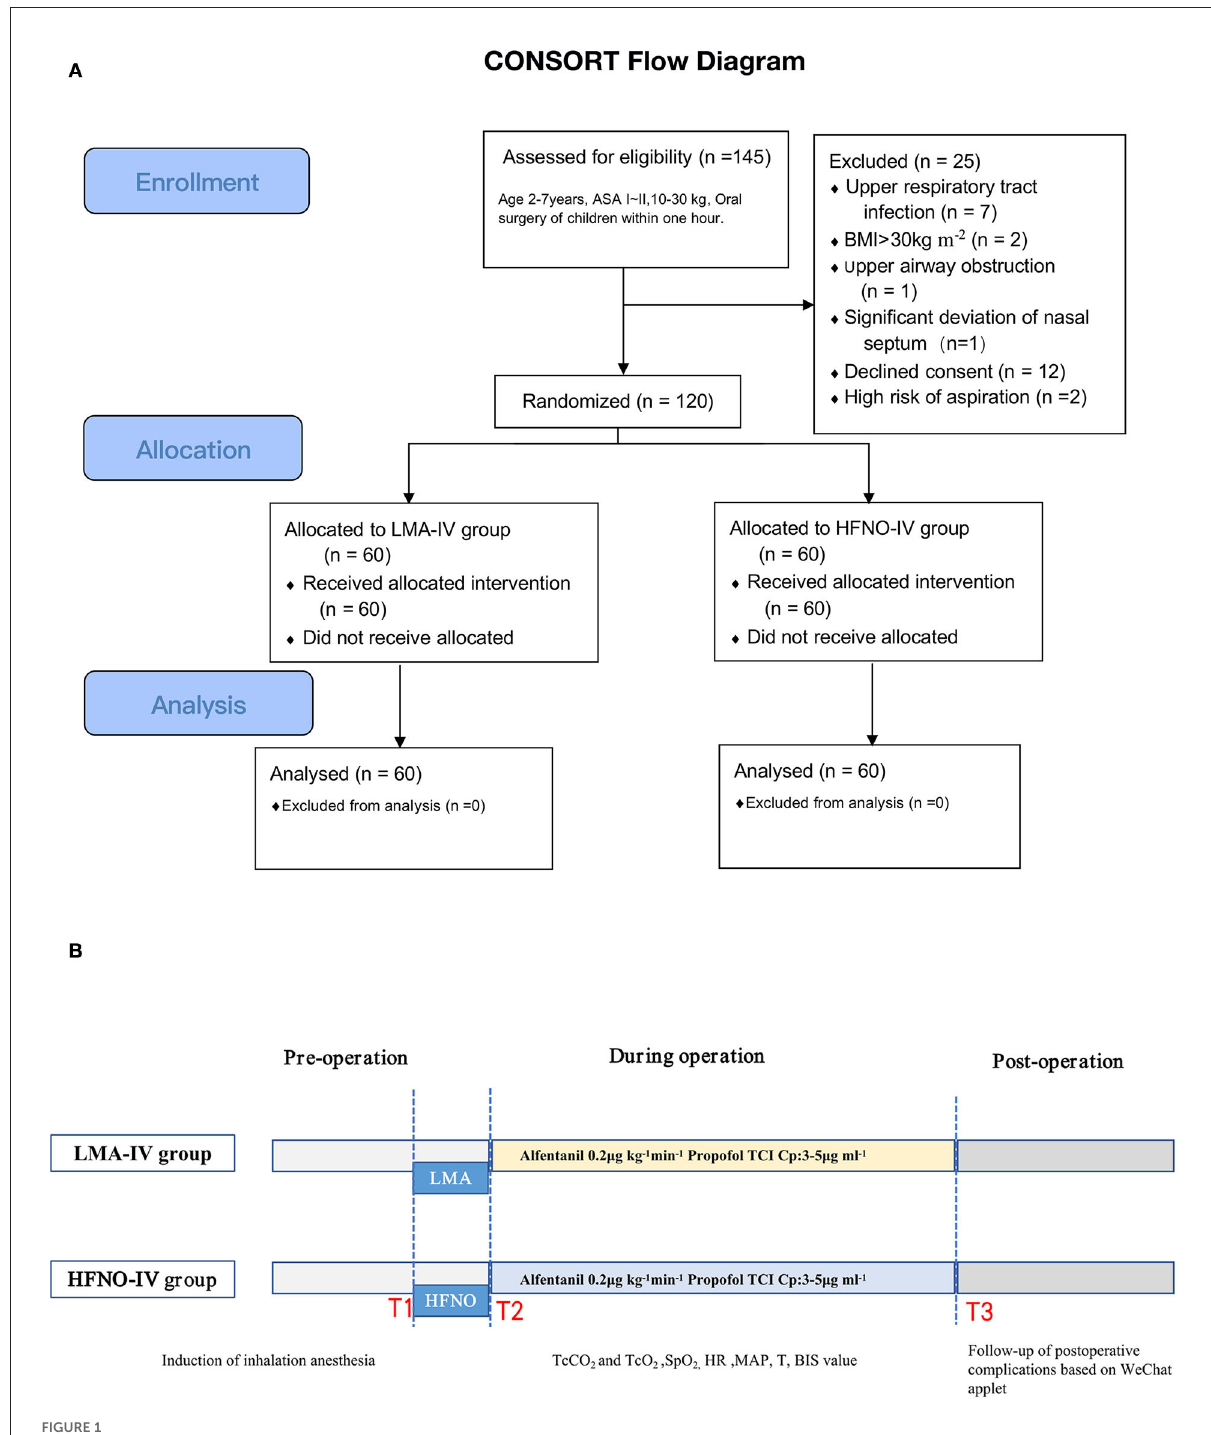
FIGURE1 (A,B) CONSORT flowchart for the randomized trial.